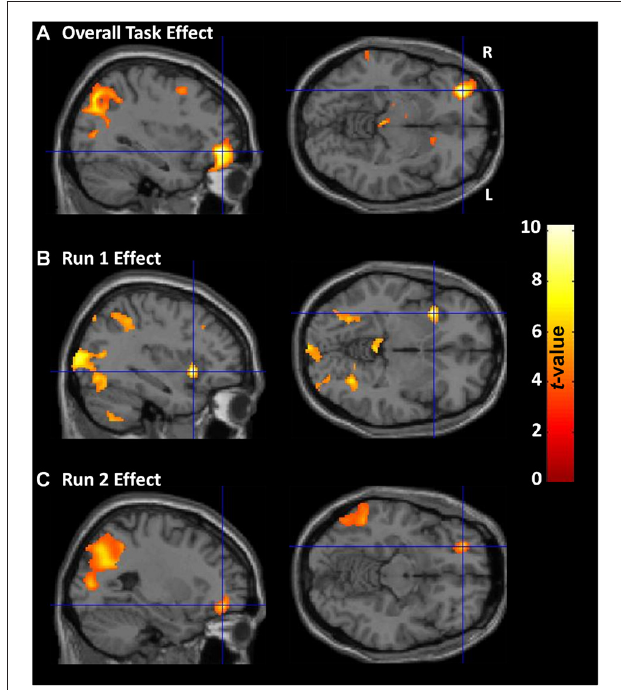
FIGURE 3 | CDMT PET outcomes. (A) Overall CDMT (i.e., both Run 1 and Run 2) performance was associated with increased regional cerebral blood flow (rCBF) in expected brain regions notably including the right lateral OFC and bilateral dorsal parietal regions. (B) Run 1 CDMT performance was associated with increased rCBF notably in the right insula and bilateral ventral parietal regions. (C) Run 2 CDMT performance was associated with increased rCBF notably in the lateral OFC and bilateral dorsal parietal regions. The images are the thresholded ( p cluster - corrected < 0.05; p voxel - level < 0.001) statistical parametric maps resulting from a one-sample t -test performed on the subject-level contrast images between the active (CDMT) minus the control (sensorimotor) task when controlling for psychopathy score, drug use severity (DUS), sex, and task performance metrics. See Supplementary Tables S1, S2 for coordinates of task-related brain